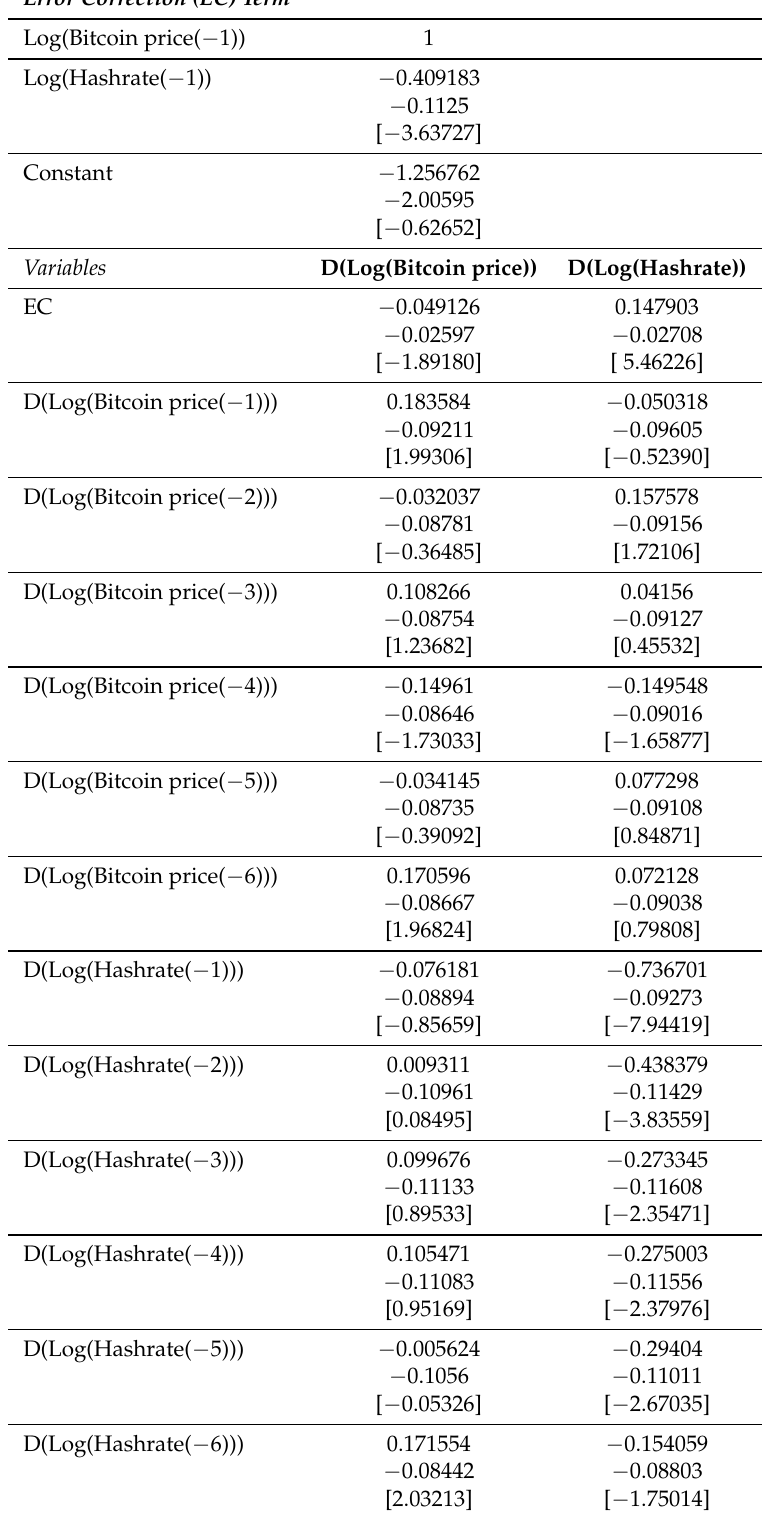
Table A6. VECM(6) for Log(Bitcoin price) and Log(Hashrate). Second sample: 11/12/2017–24/02/2020. Error Correction (EC)